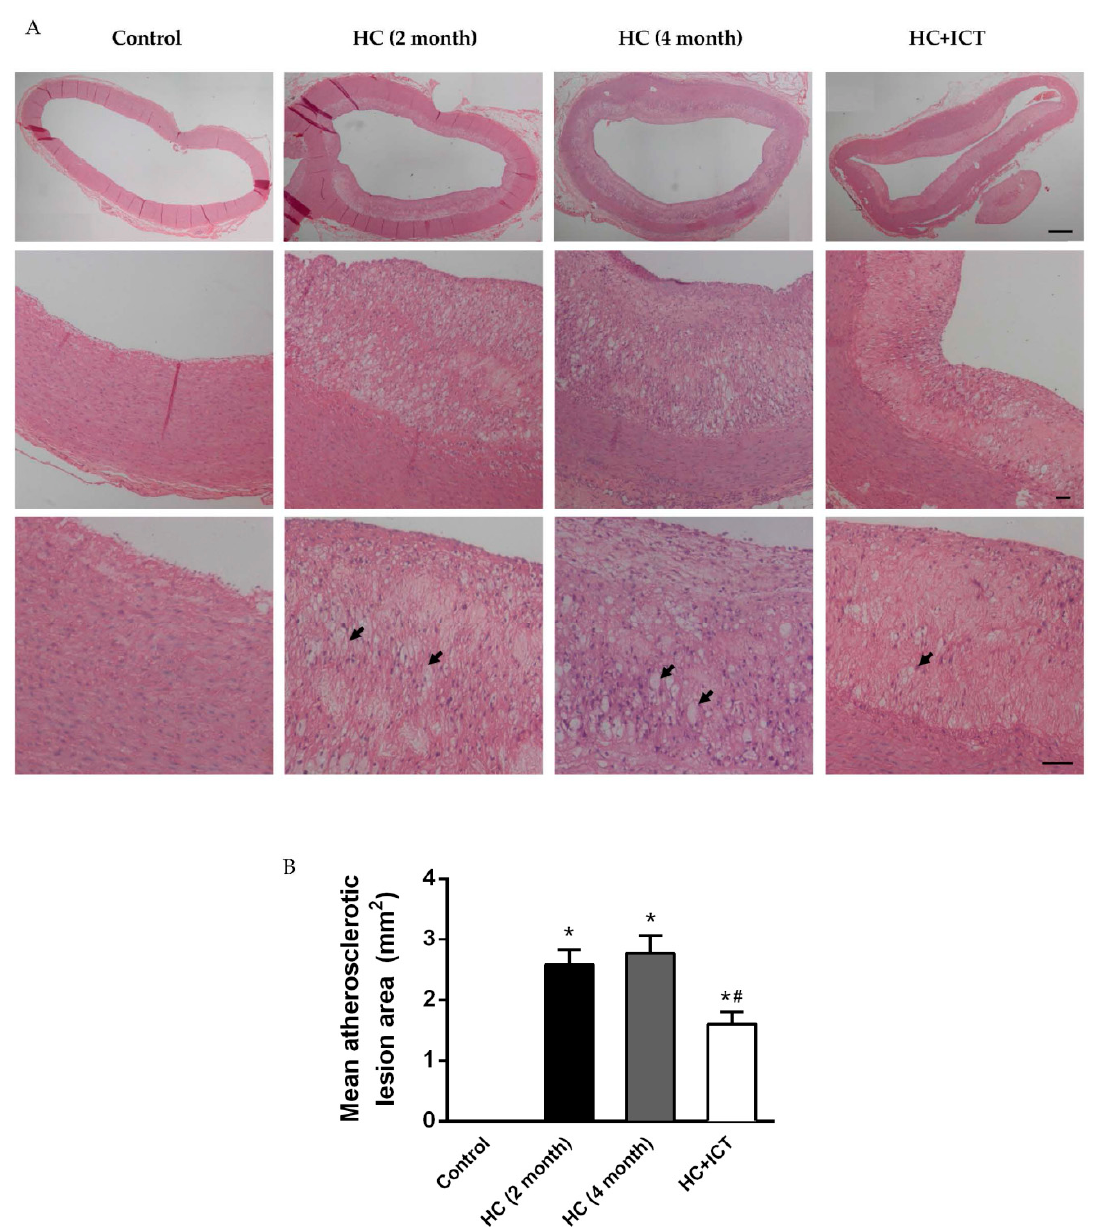
Figure 2. High cholesterol (HC) diet induced atherosclerotic lesion formation in rabbit aorta. ( A ) Representative cross sections of aorta stained by hematoxylin and eosin (H&E). Thickened intima of aorta and fatty streaks presented in all HC-fed groups compared with that from rabbits consuming standard chow (Control). Black arrow: foam cell. Scale bar = 200 µm ( top panel), 50 µm ( middle and bottom panels); ( B ) Quantitative analysis of atherosclerotic lesion area. * p < 0.05, between control and HC groups; # p < 0.05, between HC (four month) and HC+ICT groups. n = 2 in HC (2 month) group, n = 9 in the other three groups. Data were means ± SEM.